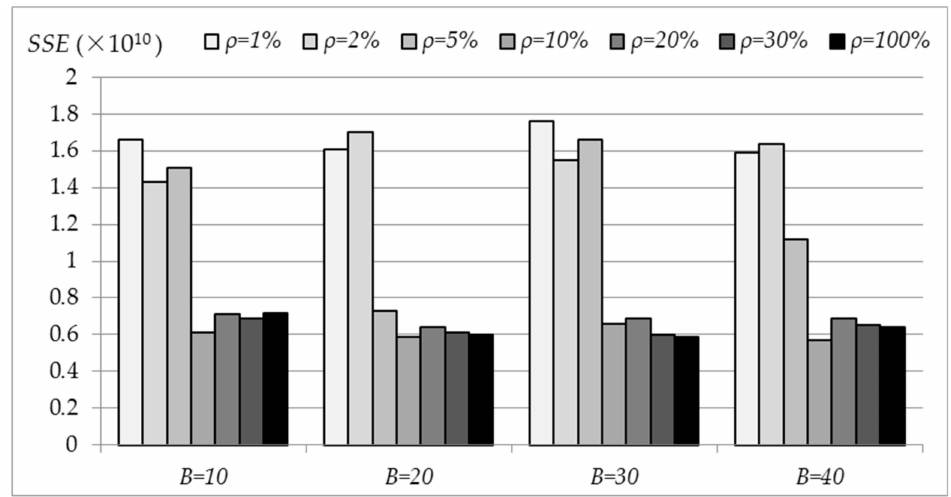
Figure 7. Variation of sum of squared errors (SSEs) for di ff erent combinations of ρ and B